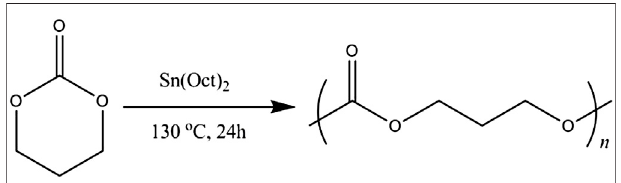
FIGURE 1 | The synthetic route of PTMC.